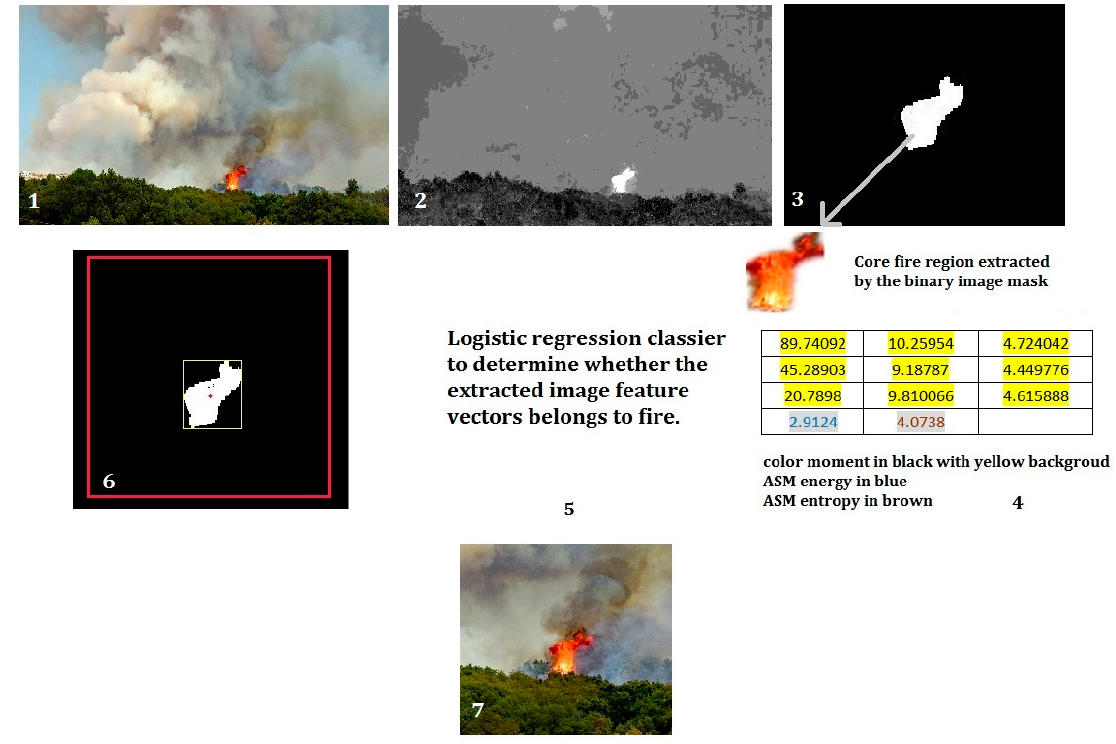
Figure 4. Example of the proposed fire localization and segmentation method.